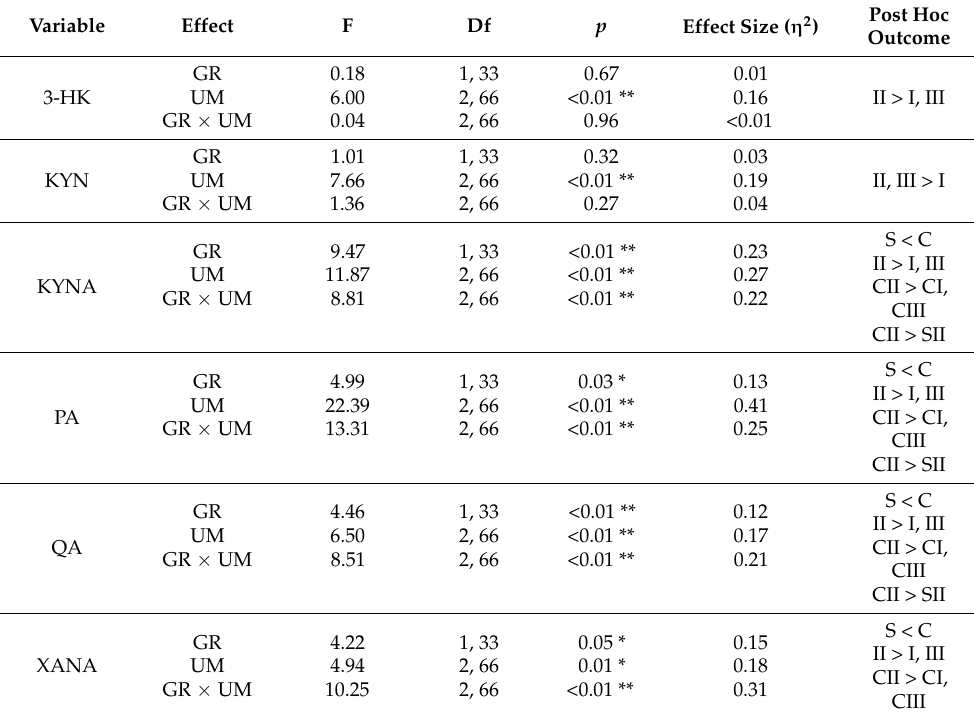
Table 1. Two-way ANOVA (2 groups × 3 repeated measures) of changes in serum KYN metabolite levels induced by ultramarathon run. Variable Effect F Df